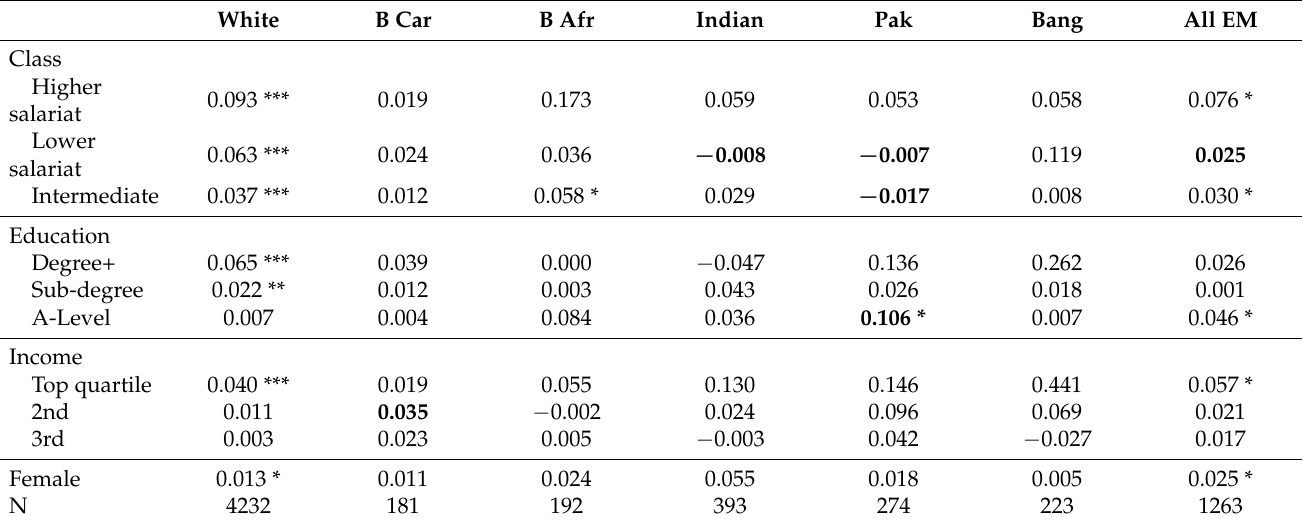
Table 7. Average marginal effects from ordinal logit regression on labour market position at age 25 on parental resources and personal attributes with predicted probabilities on access to the higher salariat. White B